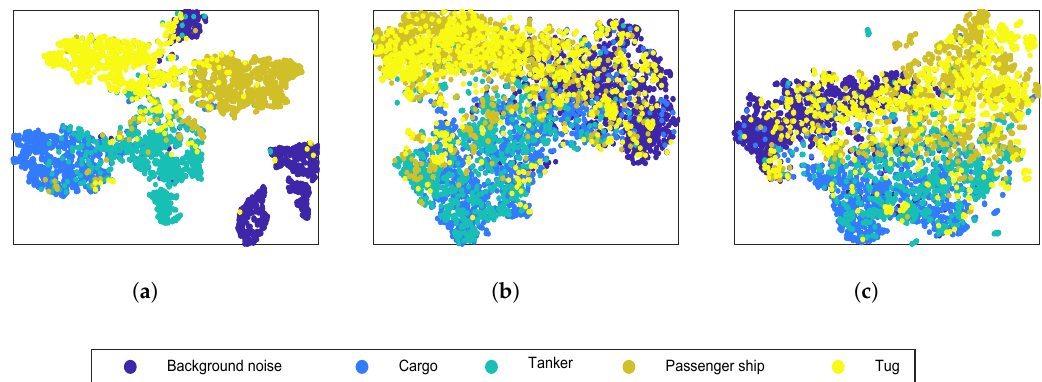
Figure 6. Feature visualization by t-distributed stochastic neighbor embedding (t-SNE). Five thousand samples selected randomly from test data were used to perform the experiments. Dots of different colors represent different types of ships. ( a ) Output of the whole network. ( b ) Learned spectrogram. ( c ) Gammatone